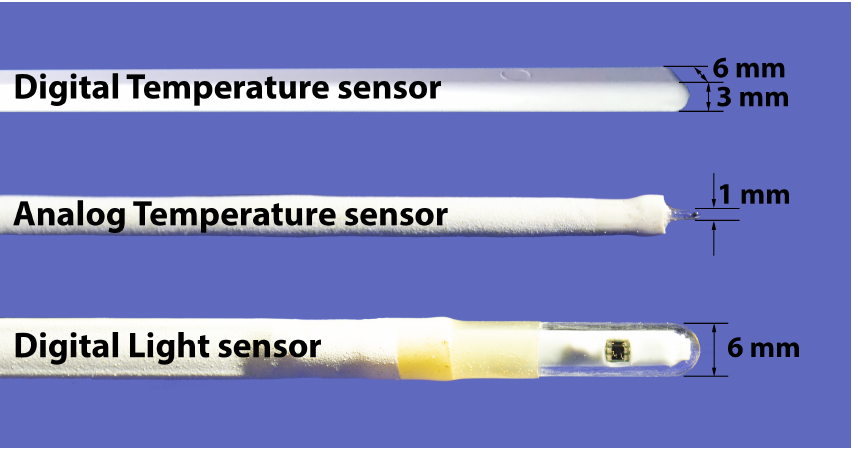
Figure 3. Temperature and light